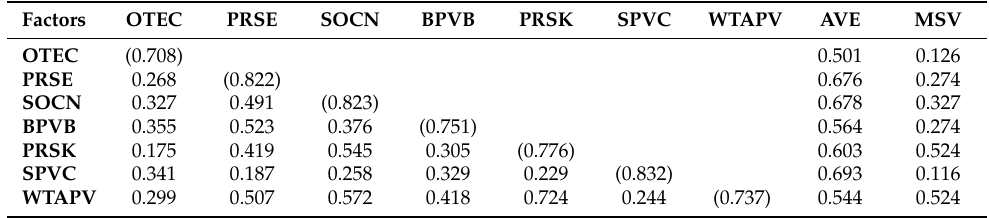
Table 6. Correlation, discriminant validity, and convergent validity